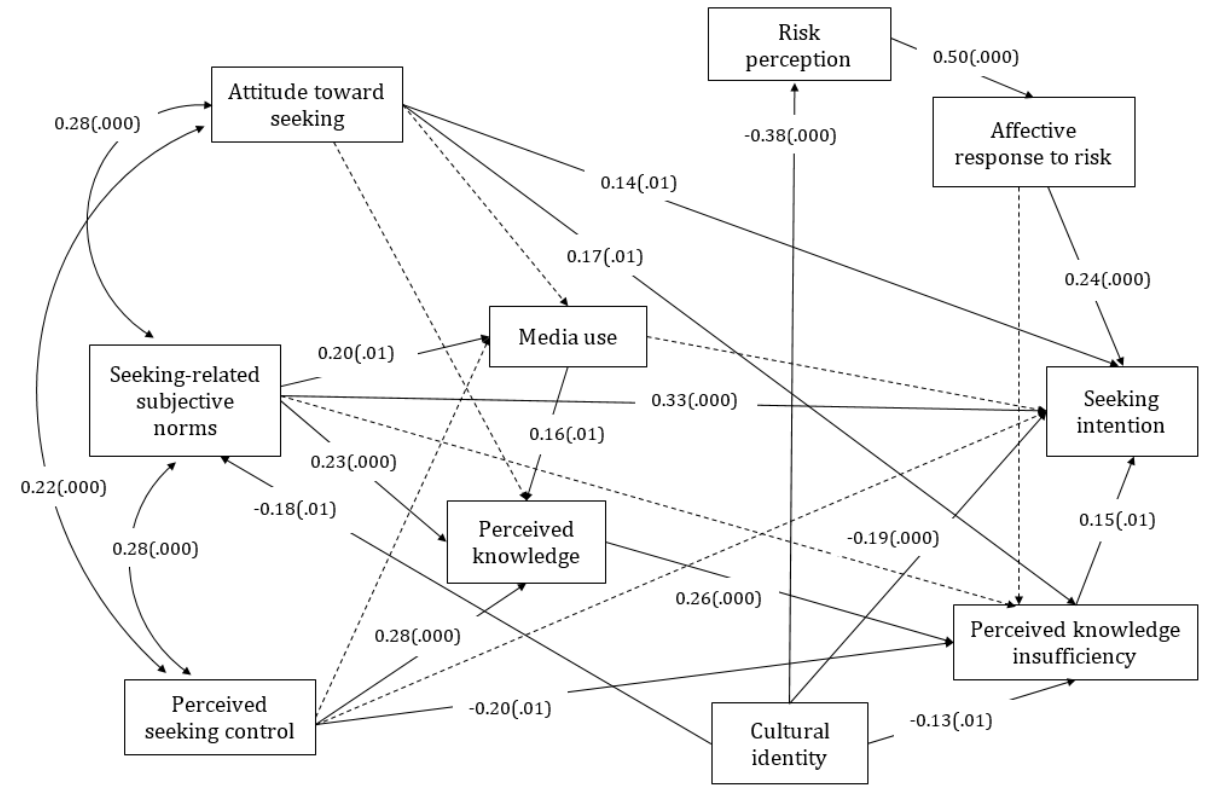
Figure 4. The extended planned risk information seeking model of the US sample. Dashed lines denote hypothesized nonsignificant paths. The model includes effects of control variables, which are not displayed. (.000) represents significant path coefficients at the .001 level and (.01), at the .05